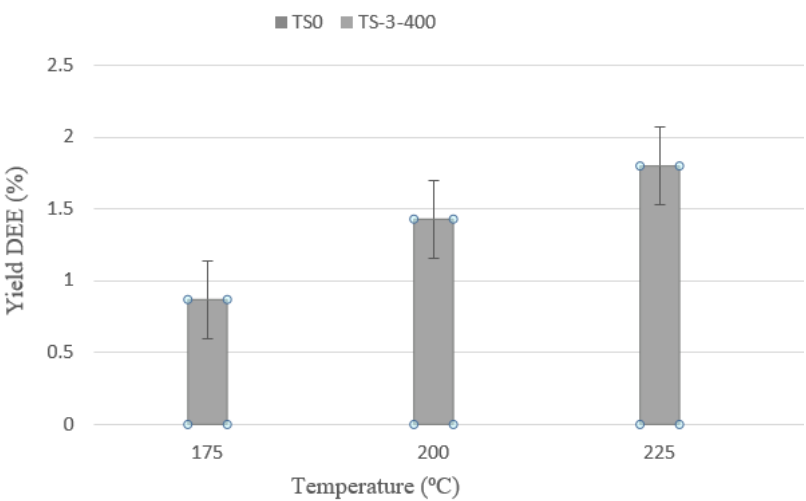
Figure 8. Yield DEE in various temperature of dehydration reaction.